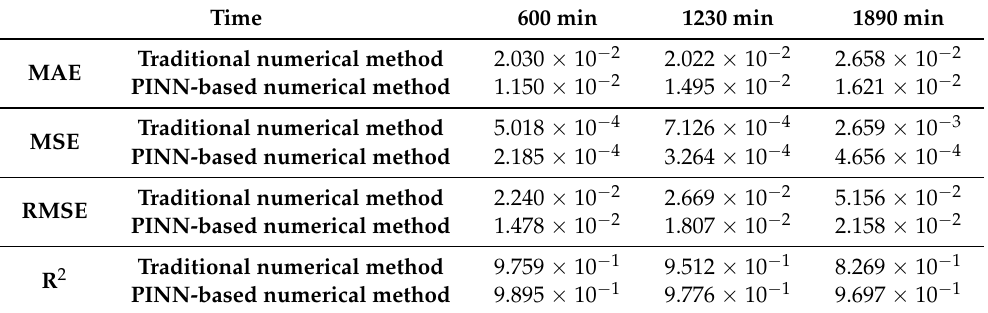
Figure 6. Soil moisture infiltration profiles at different times, ( a ) for measured and predicted soil moisture infiltration profiles at 600 min, ( b ) for measured and predicted soil moisture infiltration profiles at 1230 min, ( c ) for measured and predicted soil moisture infiltration profiles at 1890 min. Table 2. Soil moisture infiltration error